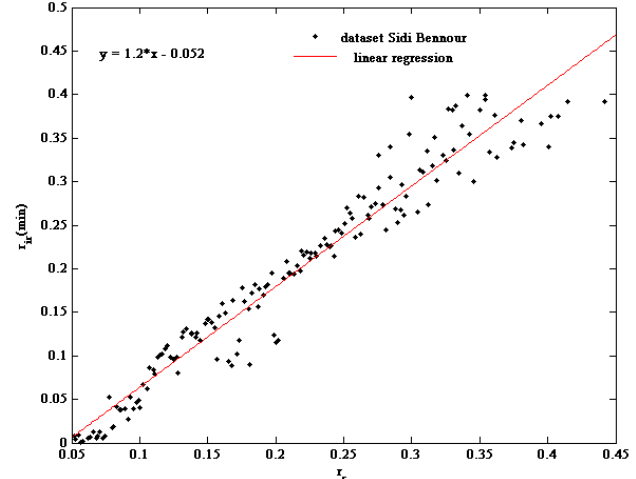
Figure 6. Scatter plot of minimum NIR vs. red reflectance and estimated soil line; Sidi Bennour district, see Table 1 for acquisition dates.